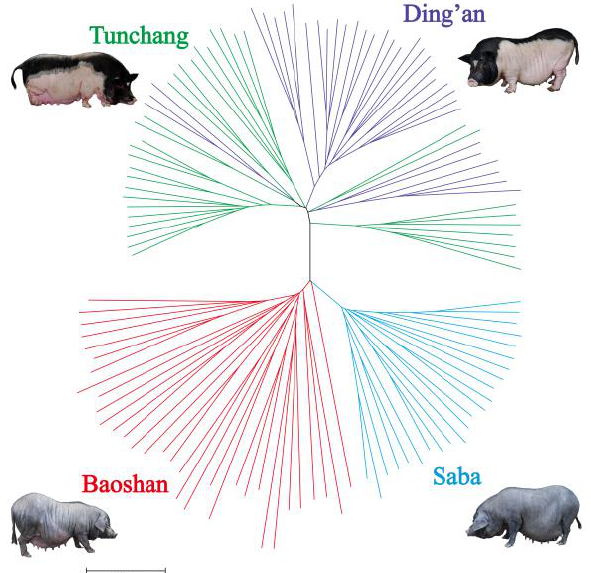
Figure 2. Phylogenetic tree based on four pig populations. The polygenetic tree was constructed based on data collected from 33 Baoshan pigs, 23 Saba pigs, 34 Ding’an pigs, and 34 Tunchang pigs. Different colors represent different pig populations. The phylogenetic tree was constructed by MEGA software (Version 7.0.14) [33] .